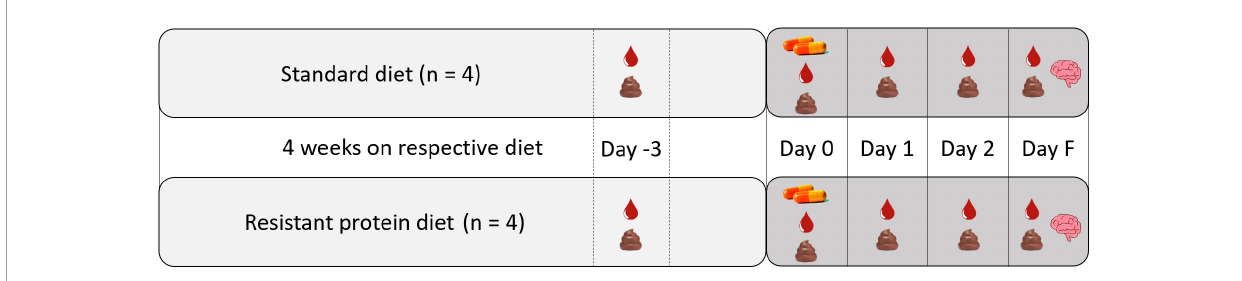
FIGURE2 Study design showing the capsule administration and sampling protocol. Blood droplet icon indicates blood sampling, feces icon indicates excreta sampling, capsule icon indicates administration of capsules, brain icon indicates terminal sampling of tissues and organs.